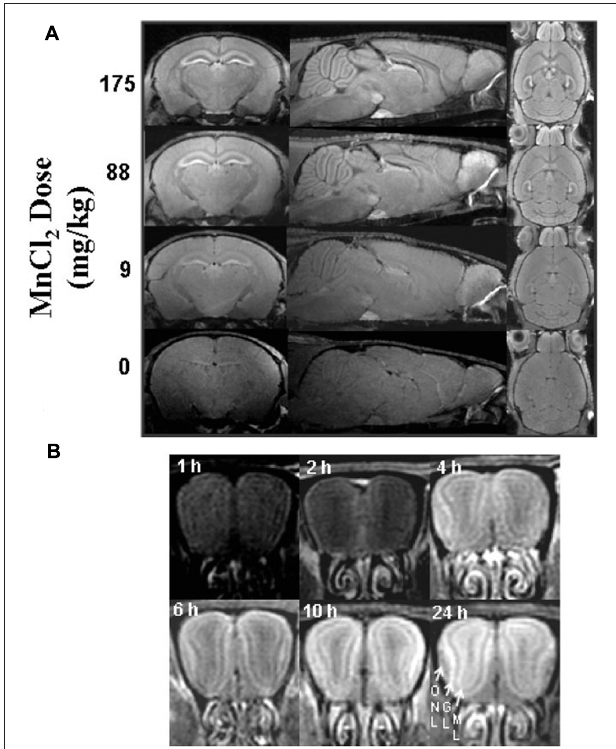
FIGURE 2 | Signal intensity depends on dose and time. Adapted with permission from Lee et al. (2005). Scans performed in mice with intact blood-brain barrier showing the dependence of signal enhancement on (A) dose and (B) time. (A) Manganese produces global enhancement that scales with dose. Enhancement is most significant in the hippocampus, interpeduncular nucleus, pituitary, and olfactory bulb. (B) Enhancement of signal increases over time as demonstrated in the olfactory bulb (ONL, olfactory nerve layer; GL, glomerular layer; ML, mitral cell